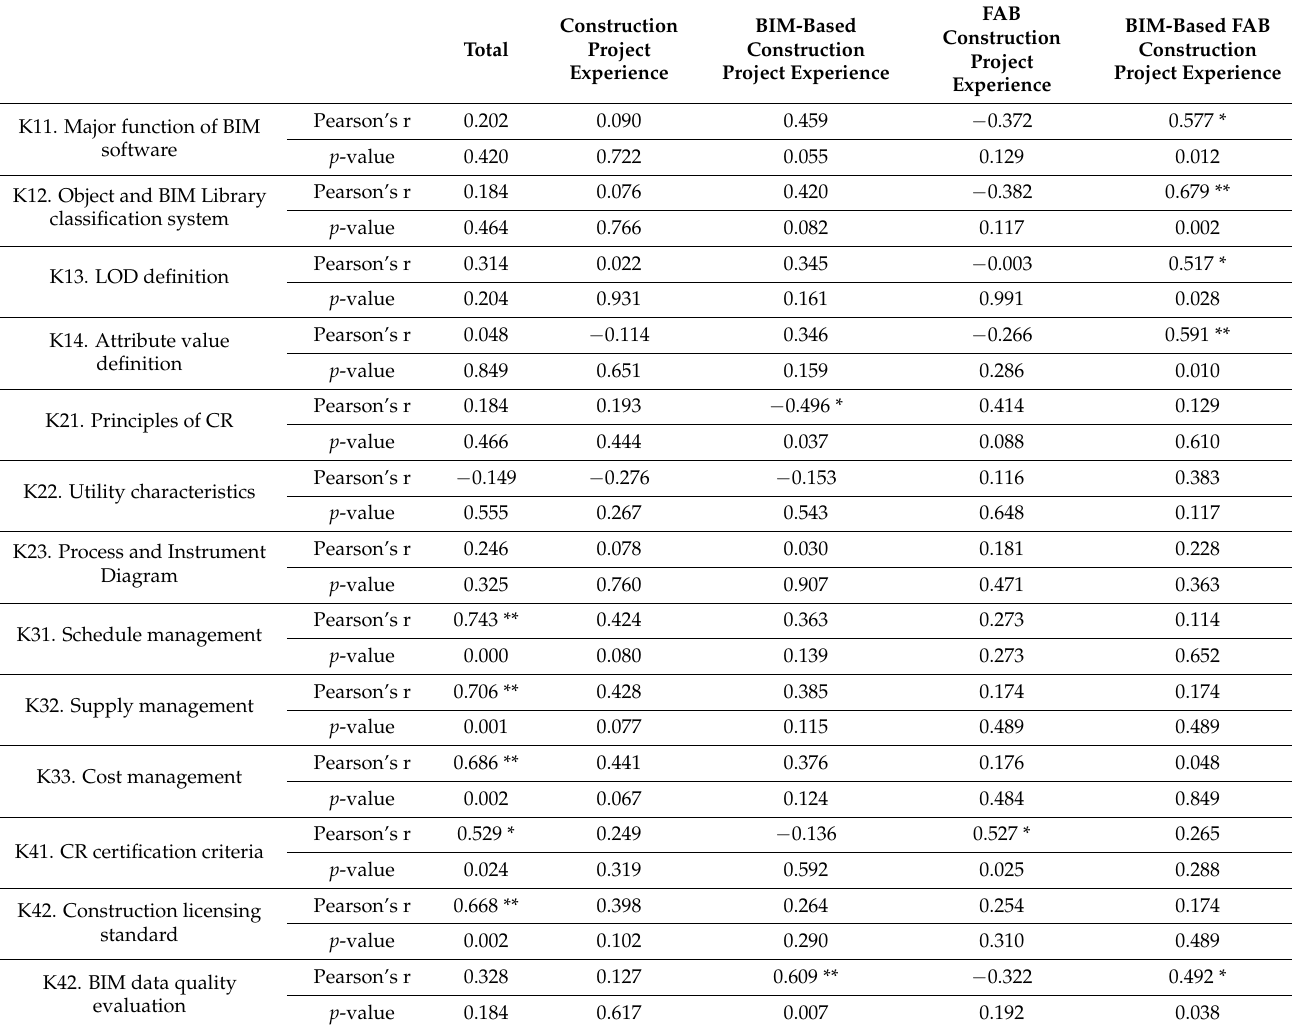
Table 7. Analysis of correlation between ‘Knowledge’ domain competencies and career characteristics of the owner